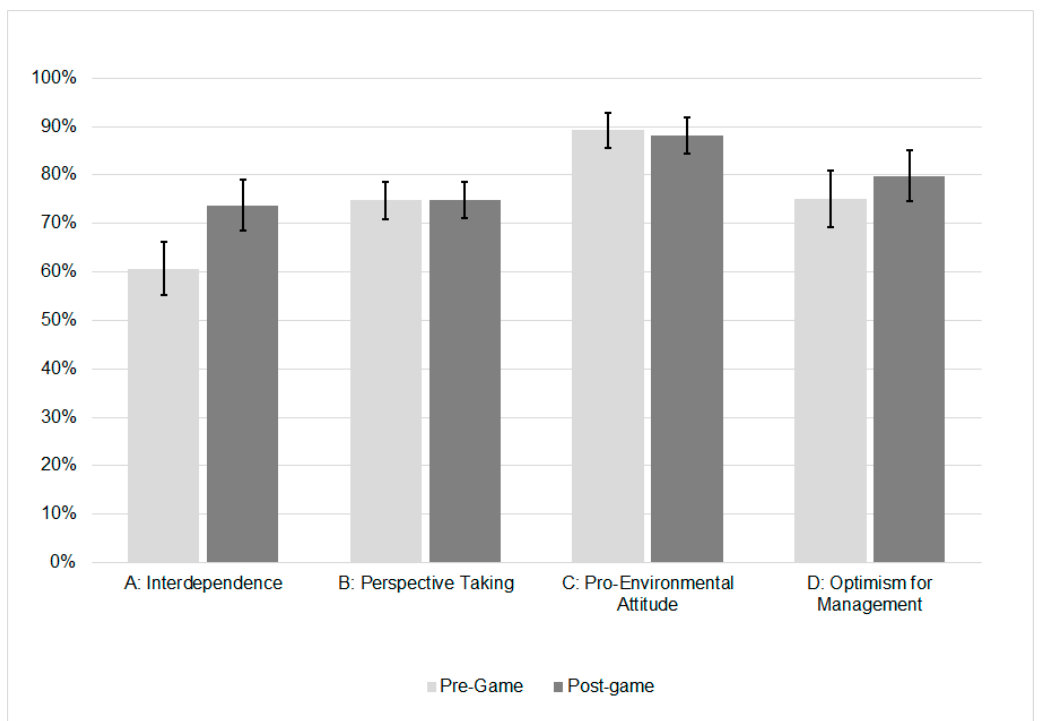
Figure 3. Average ratings on four scales for pre-game and post-game surveys, and error bars illustrating the 95% margin of error. Means and margins have been converted into percentages of each scale’s maximum to facilitate comparison.